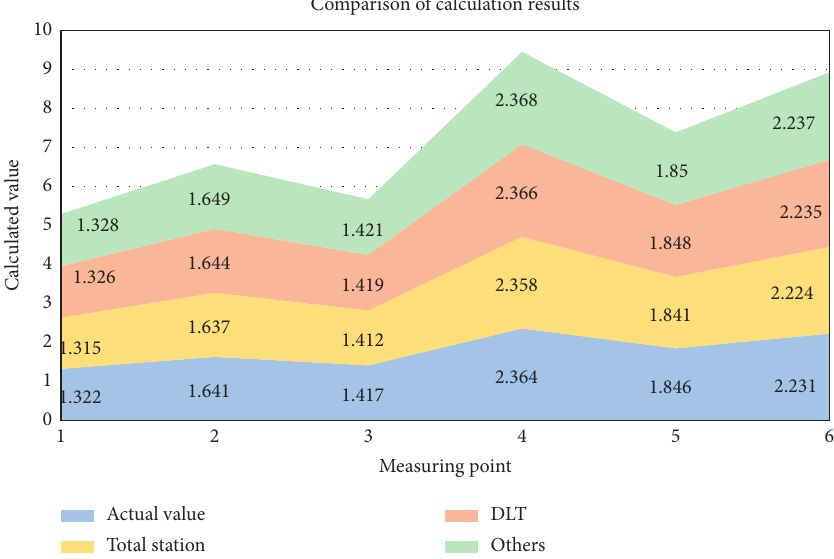
Figure 6: Comparison of calculation results of different